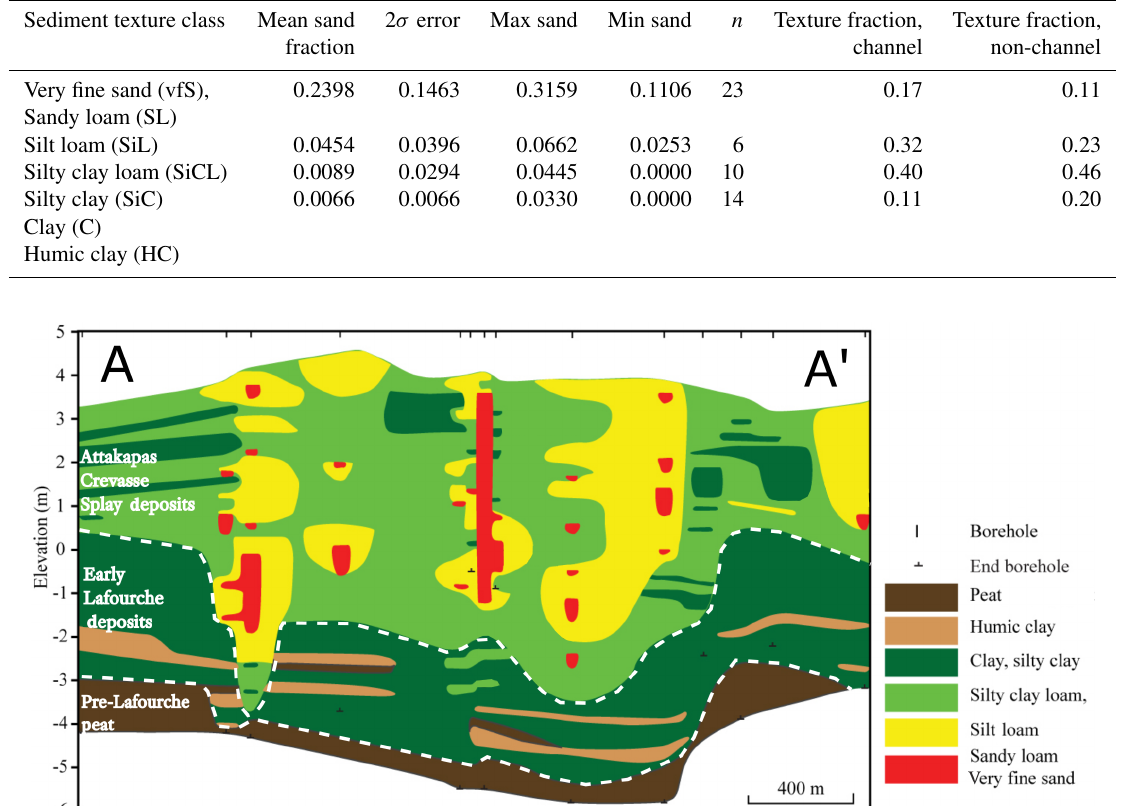
Figure 4. Stratigraphic cross section along transect A to A (cid:48) (see Fig. 1b for location), adapted from Shen et al. (2015). Our 3-D model (Fig. 3) considers only sediments preserved above the clay to silty clay loam transition. Channel bodies can be seen as deposits of coarser material, often corresponding to alluvial